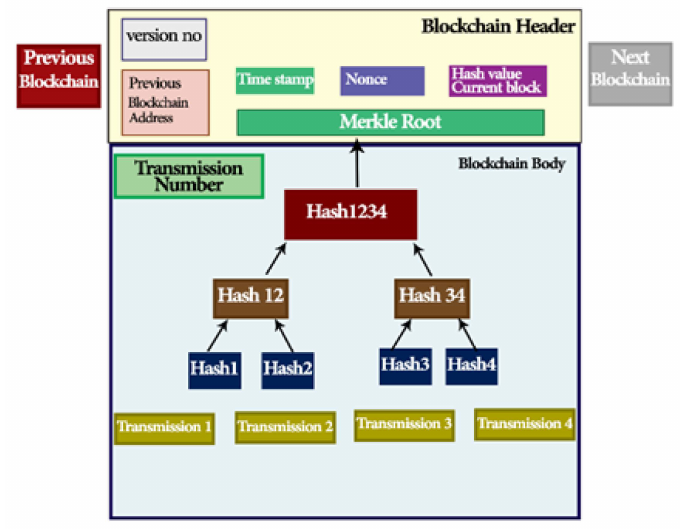
Figure 2. Structure of blockchain.